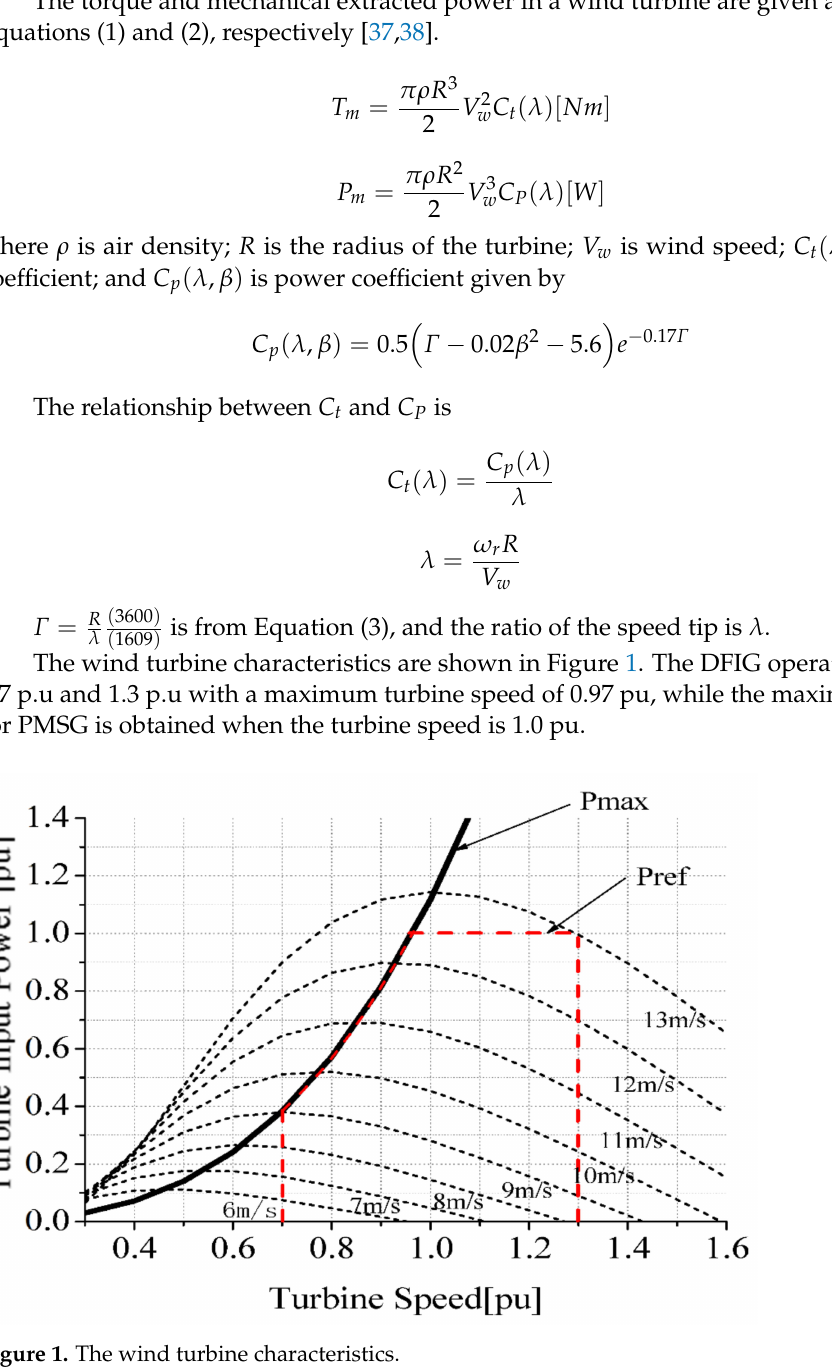
Figure 1. The wind turbine